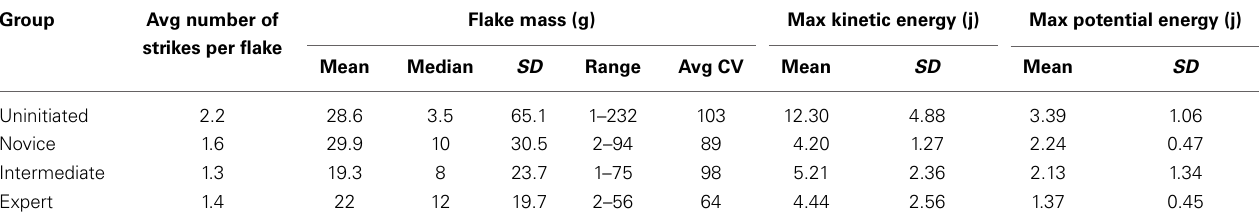
Table 2 | Summary statistics of flake mass and regulation of kinetic energy by group. Group Avg number of Flake mass (g) strikes per flake